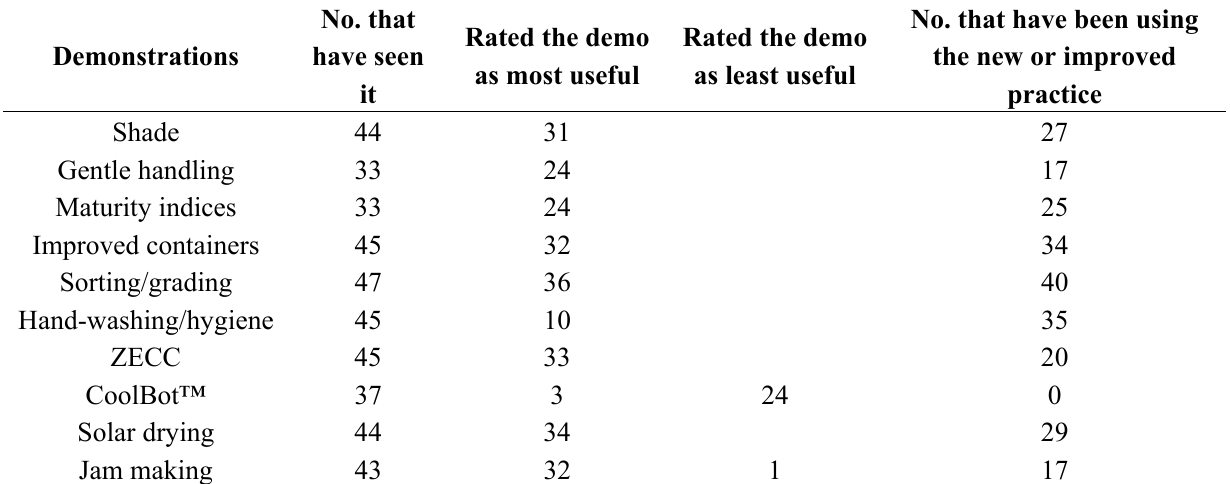
Table 2. Training participant ratings of postharvest